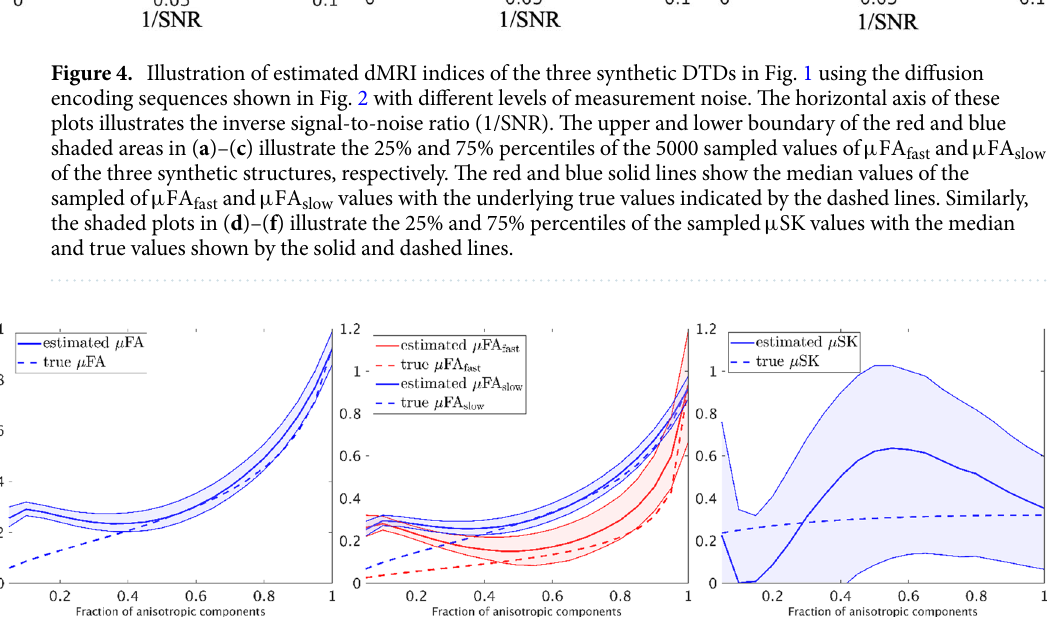
Figure 5. Illustration of accuracy and precision of the estimated dMRI indices of the synthetic DTDs in Fig. 1c with varying fraction of anisotropic components. The upper and lower boundary of the shaded areas illustrate the 25% and 75% percentiles of the estimated indices in simulations. The solid red or blue lines show the mean value of the estimated indices and the corresponding dashed lines show the underlying true values. The SNR of the simulated signals is equal to